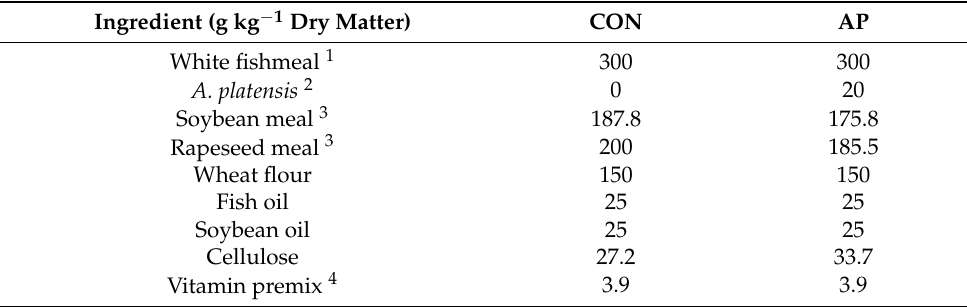
Table 1. Diet formulation and chemical compositions of the experimental